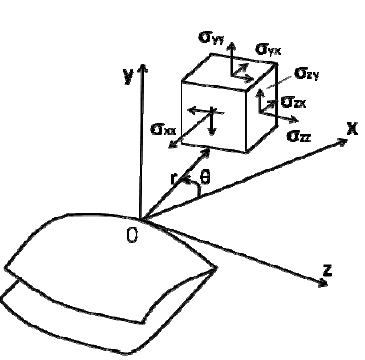
Figure 1: Stress components in the vicinity of the crack